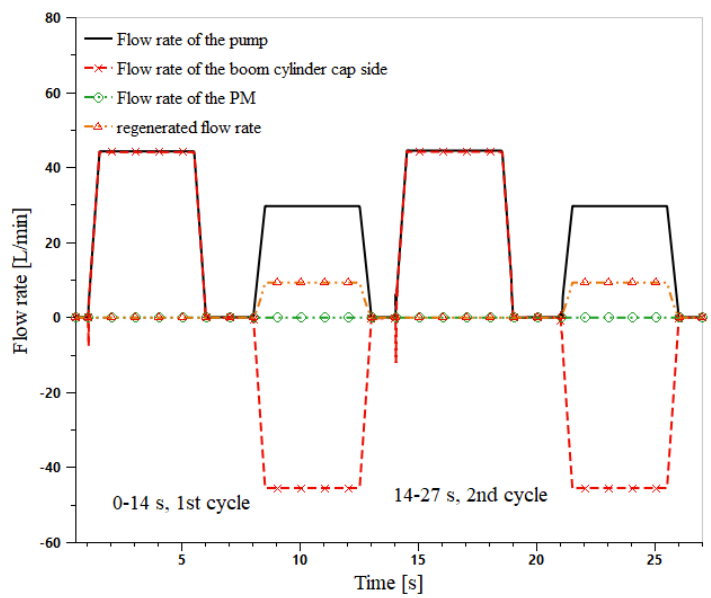
Figure 10. Flow rate curves in the original system.